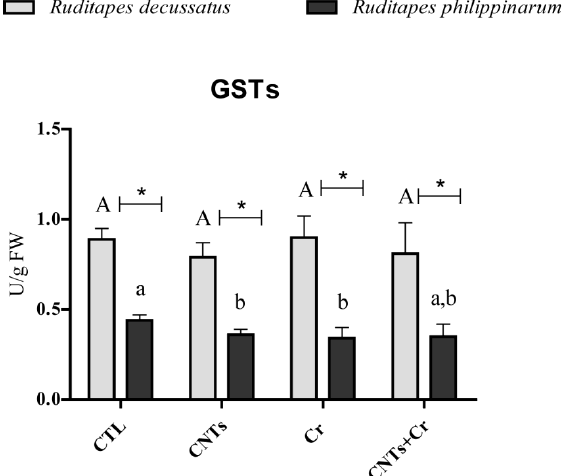
Figure 4. Glutathione S-transferases (GSTs) activity (mean values+ standard deviation), in Ruditapes decussatus (light gray bars) and Ruditapes philippinarum (dark gray bars) after a 28-day exposure period. For each species, tested treatments were: control (CTL), carbon nanotubes (CNTs), chromium (Cr), and the combination of both contaminants (CNTs + Cr). Significant differences ( p < 0.05) among treatments are represented with different letters (lowercase for R. decussatus and uppercase for R. philippinarum ). For each treatment, significant differences ( p < 0.05) between R. decussatus and R. philippinarum are represented with an asterisk (*).